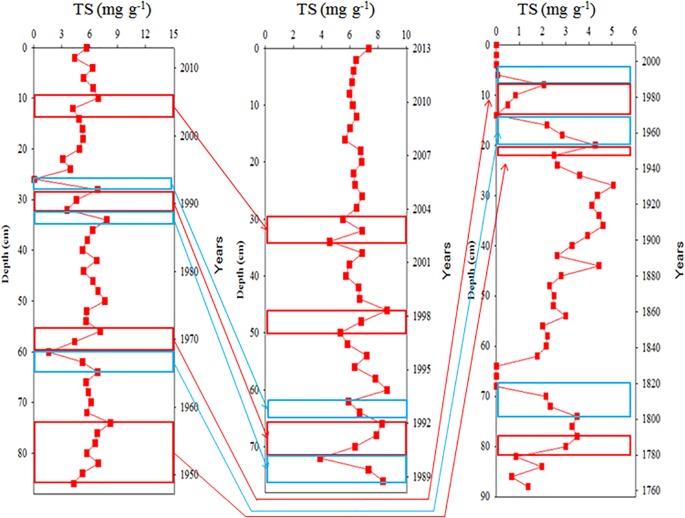
Temporal variations TS in three core sediments and similar time spans of increased or decreased trends of TS among three cores.From left to right panels are Core Ks2, Ks3 and S2, respectively.